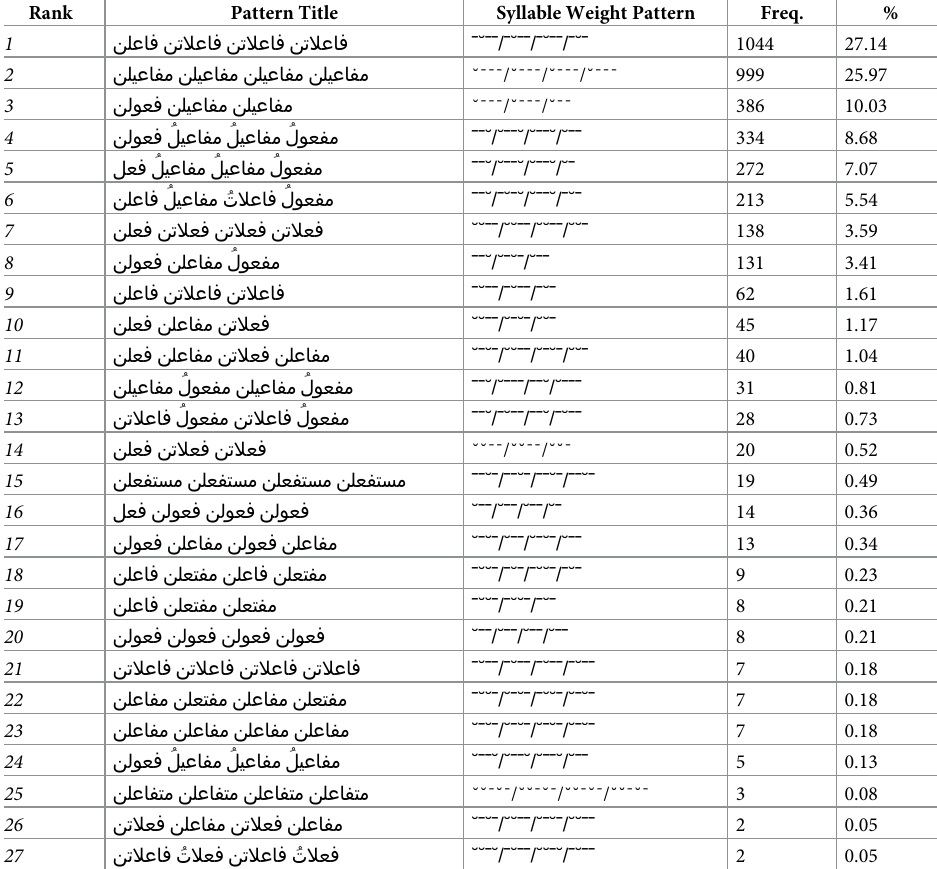
Table 5. Common patterns of Kurdish quantitative verses (VejinBooks corpus, up to 2019/12/1).